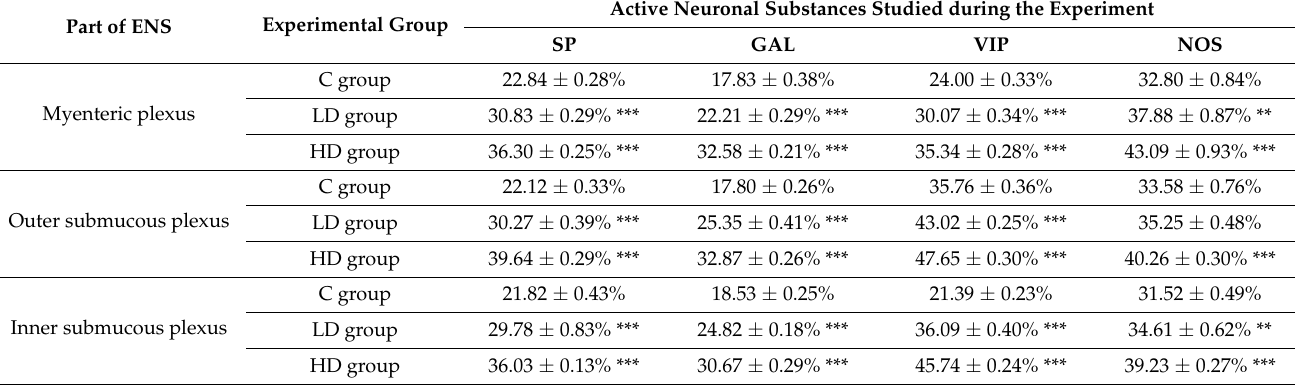
Table 2. Co-localization of NRG1 with other neuronal active substances under physiological conditions (C group) and after BPA administration in the low dose (LD) group and high dose (HD) group in ascending colon.